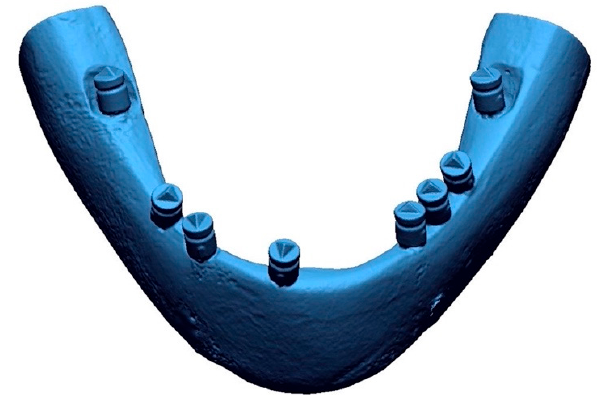
Figure 1. Working model with scan bodies attached to implants.